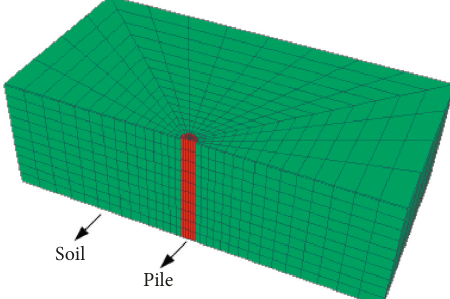
Figure 9: Pile-soil FLAC3D shear